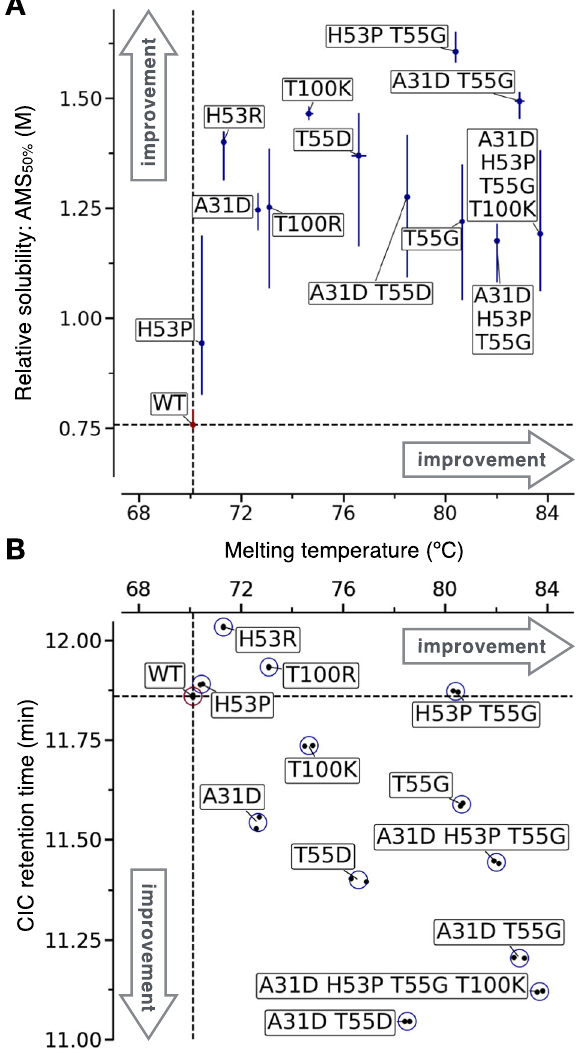
Fig.4|ExperimentalcharacterisationofdesignednanobodyNb.b201variants. A Scatter plot of the melting temperature (T m ) against the ammonium sulphate midpoint of precipitation (AMS 50% , used as a proxy for relative solubility). Vertical error bars are the 95% con fi dence interval on the fi tted AMS 50% , horizontal error bars, which are often smaller than the data point, are standard deviation over two independent melting experiments (which are shown individually in B ). B Scatter plot of the measured T m against the cross-interaction chromatography (CIC) retention time. Data from two independent experiments (black points) are repor- ted. In both panels the dashed lines are drawn across the mean measurements of the WT Nb.b201 (red